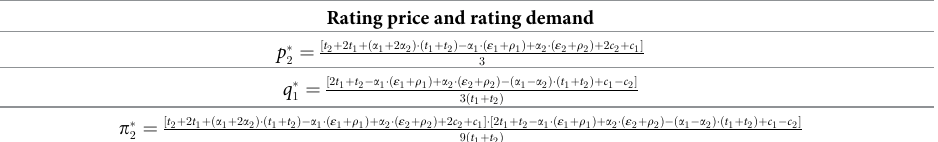
Table 4. Long-term equilibrium solutions of GRAs. Rating price and rating demand